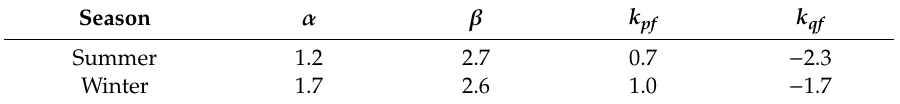
Table 1. Exponents and sensitivity factors of active and reactive power to voltage and